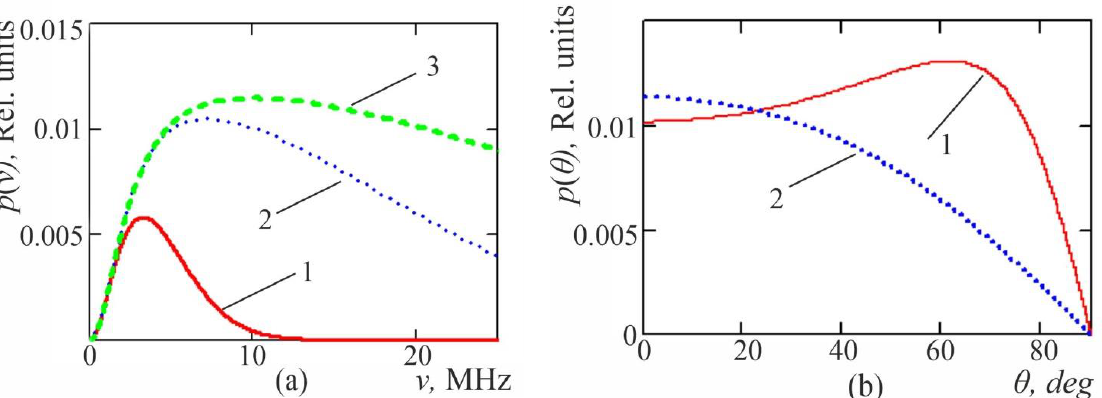
Figure 3. Spectra and indicatrices of US generated in channels with different radii. As was shown earlier, it follows from the data in Figure 3a that the smaller the channel diameter, the wider the generation spectrum and the wider the radiation pattern. ( a ) Generation of US pressure p ( ν ) spectra in channels with radii 1–500, 2–100, 3–0.4 μm. ( b ) US pressure versus angle θ at a frequency of 1 MHz (2) and 5 MHz (1) when generated in a channel with a radius of 1 μm.